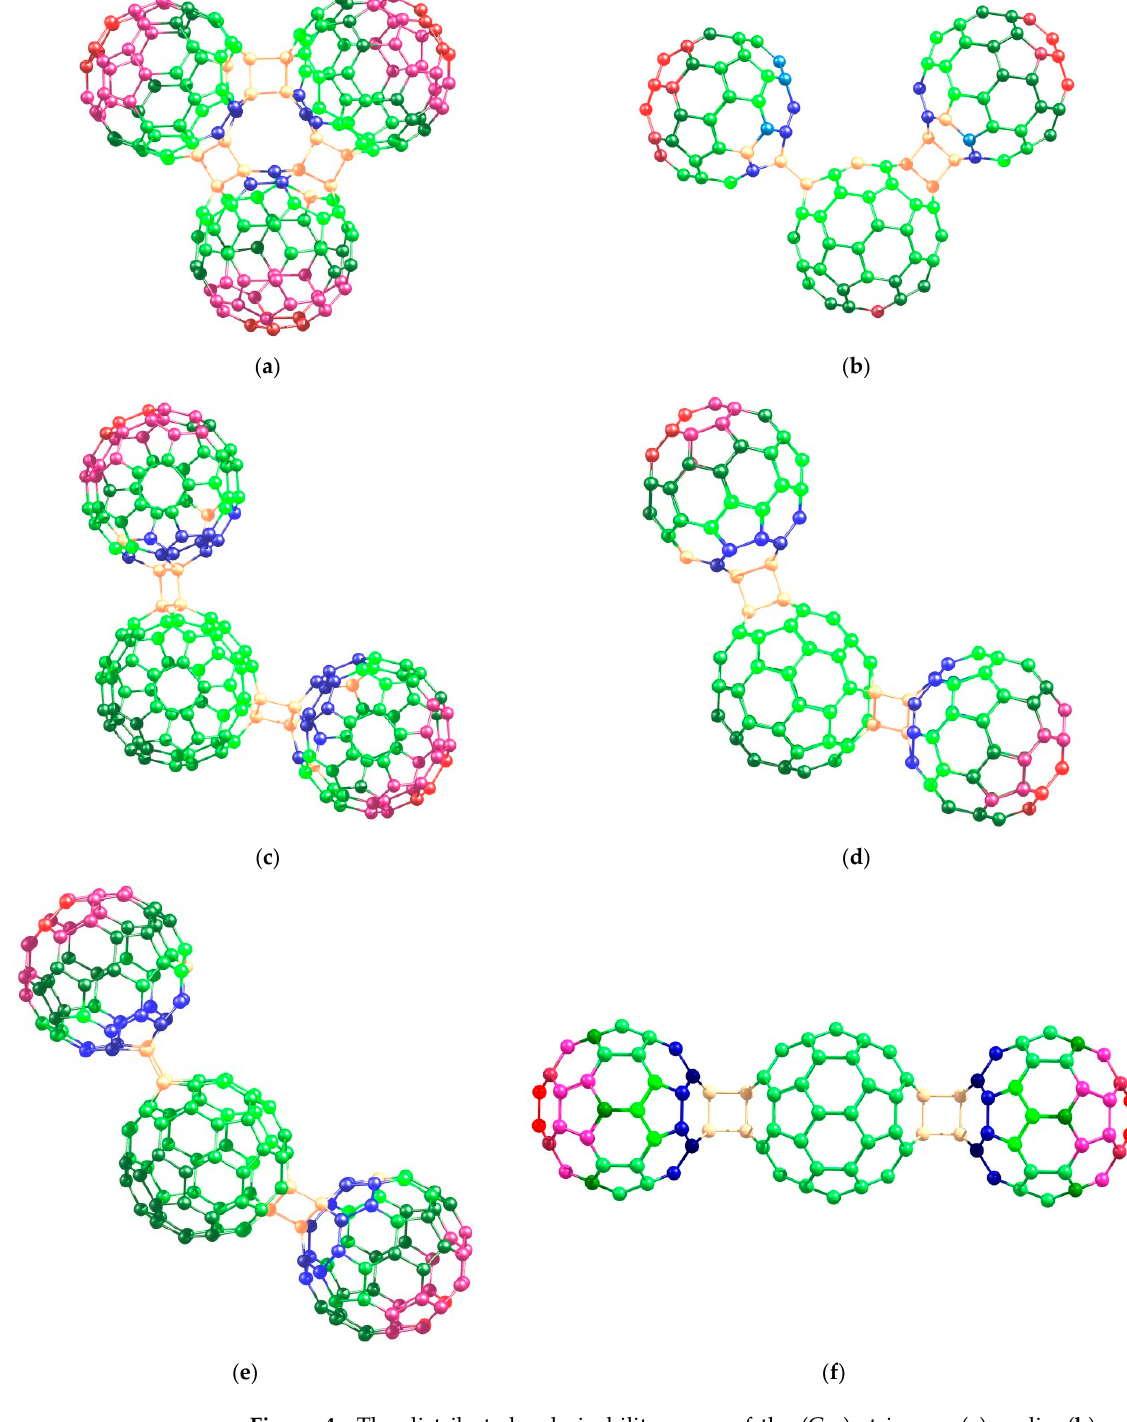
Figure 4. The distributed polarizability maps of the (C 60 ) 3 trimers: ( a ) cyclic, ( b ) e , ( c ) trans -4, ( d ) trans -3, ( e ) trans -2, and ( f ) trans -1. Color code: blue—negative atomic contributions; other colors— positive atomic contributions: beige (0%–4%), green (5%–68%), pink (69%–96%), and red (96%–100%) correspond to the percentage of the contribution relative to the maximal contribution to the dipole polarizability of the nanostructure.